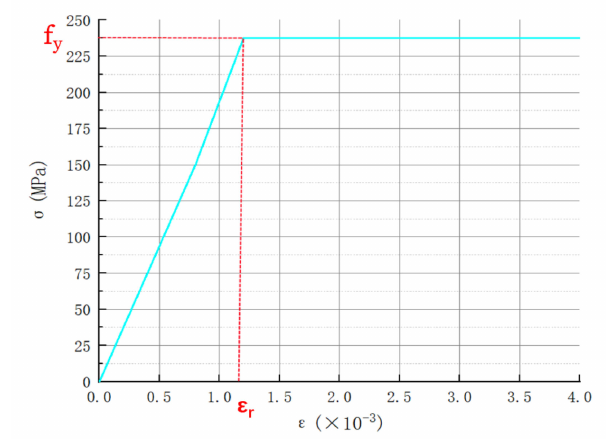
Figure 10. Constitutive relations of the steel sheet.